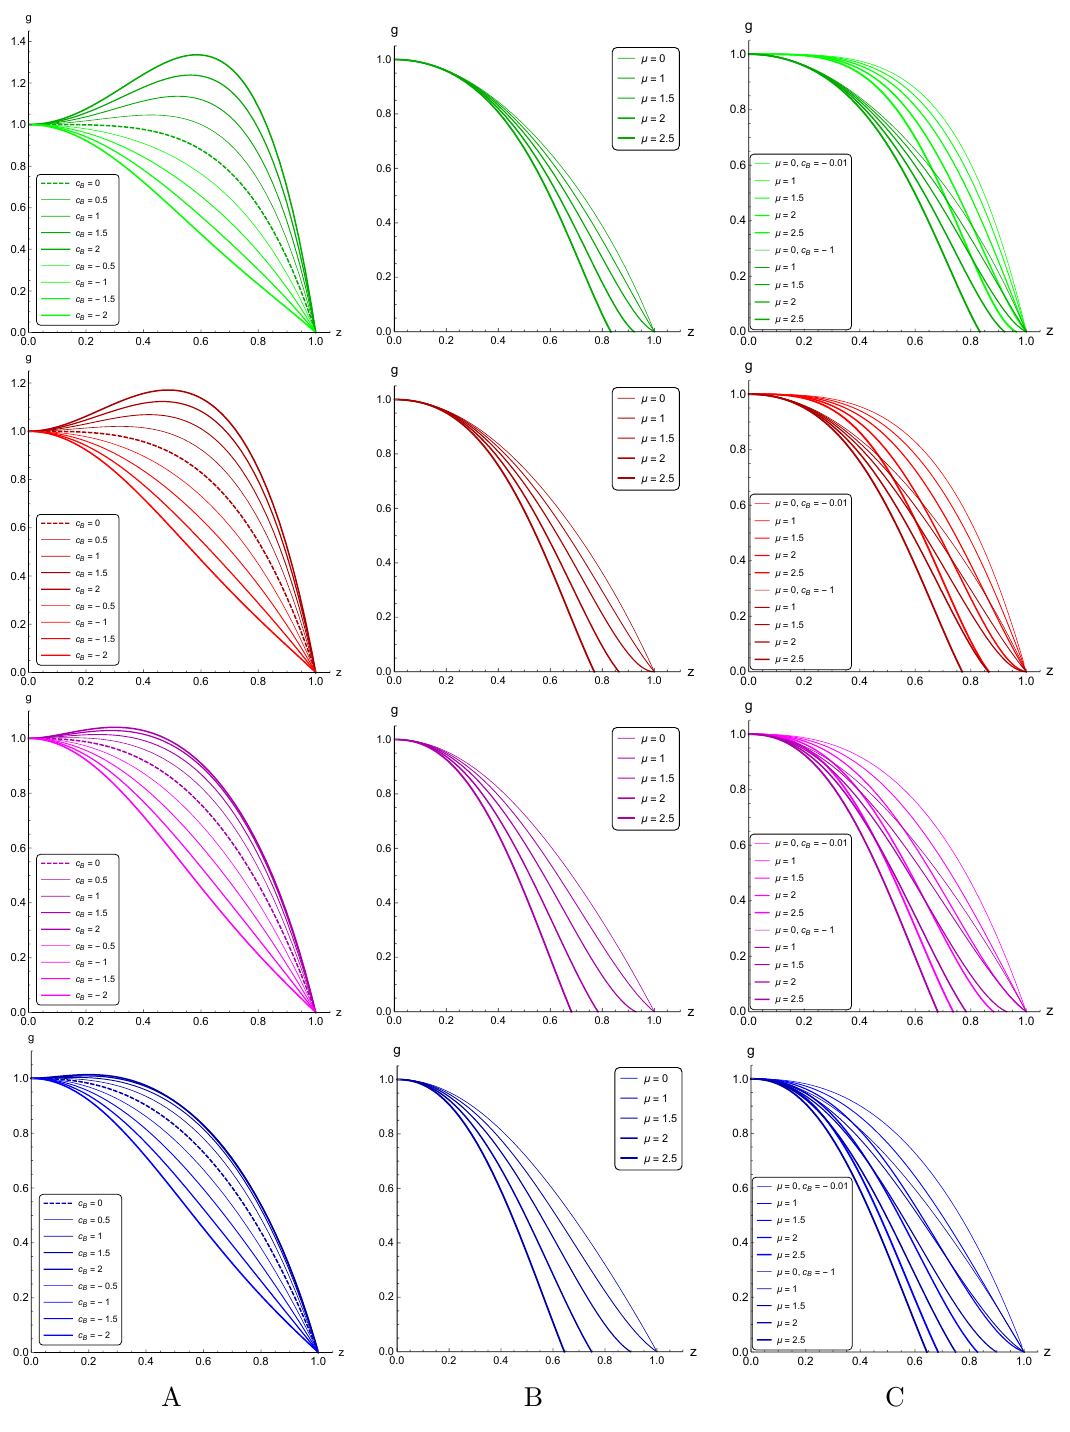
Figure 1 . Blackening function g ( z ) for different c B , µ = 0 (A), for different µ , c B = − 1 (B) and for different µ , c B = − 0 . 01 (light curves) and c B = − 1 (dark curves) (C); ν = 1 (1-st line), ν = 1 . 5 (2-nd line), ν = 3 (3-rd line) and ν = 4 . 5 (4-th line), c = 0 . 227 , z h = 1